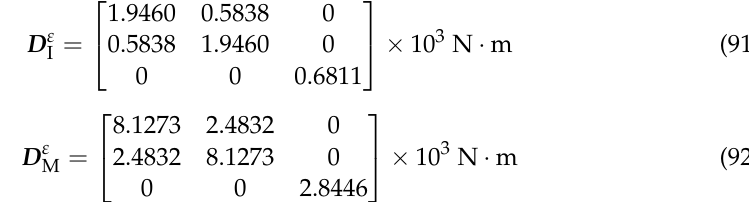
Example 2: Free vibration of an SSSS four-layer periodic plate Consider a four-layer periodic plate with a size 𝐿 1 × 𝐿 2 × ℎ = 30 cm × 30 cm × 1 cm . The plate consists of 10 × 10 unit cells with a size 𝑎 1 × 𝑎 2 = 3 cm × 3 cm , as shown in Figure 1. Material properties are listed as follows: Inclusion: Young’s modulus 𝐸 I = 10 GPa ; Poisson’s ratio 𝑣 I = 0.3 ; Density 𝜌 I = 1958 kg/ m 3 .